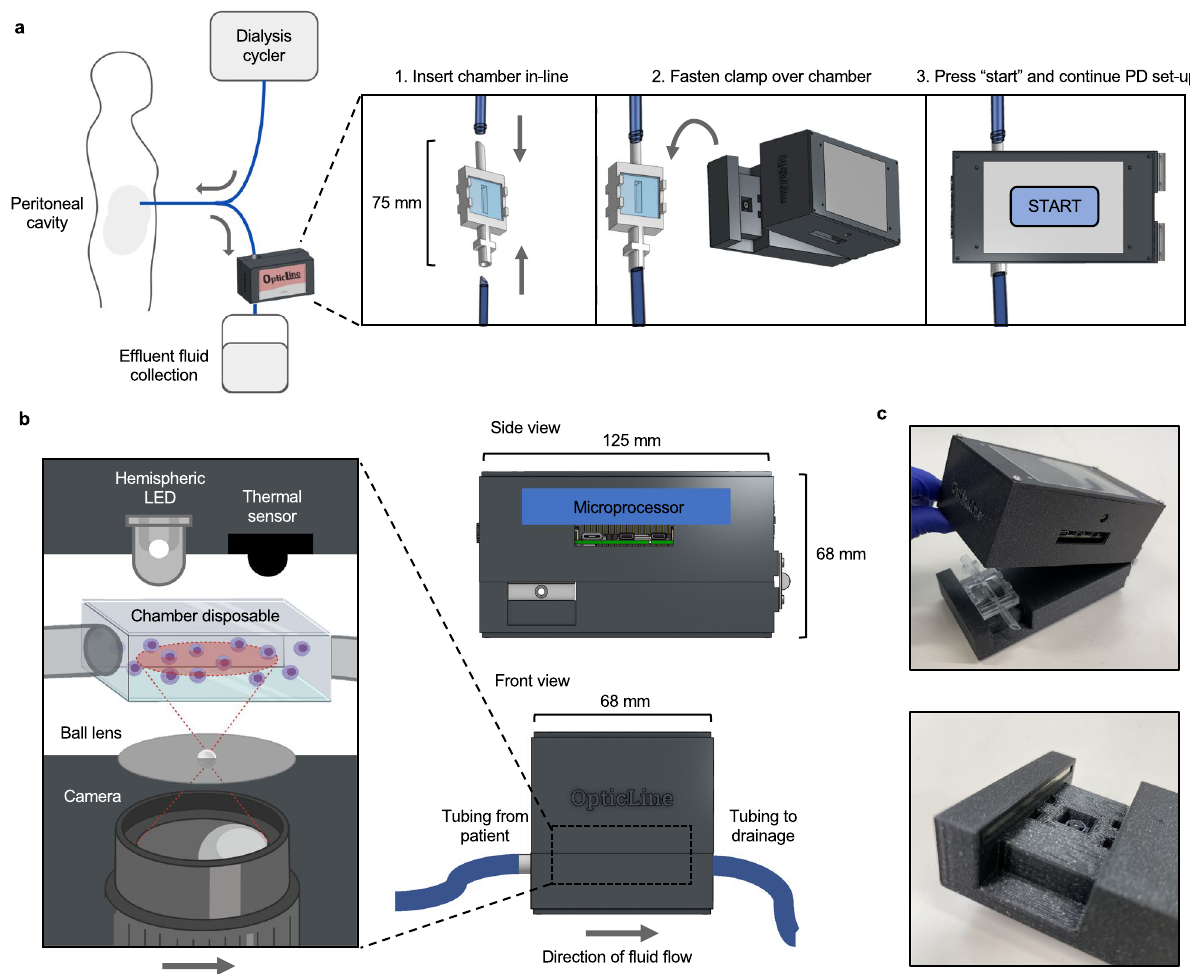
Figure 1. Overview of OpticLine use and mechanical construction. ( a ) The OpticLine chamber is inserted in-line with the drainage tubing, between the drain line and effluent fluid collection, when the patient is setting up for their peritoneal dialysis (PD) session. The OpticLine clamp then clamps over the chamber and images effluent as it flows through the clamp during drain times. The user interacts with the device via a touchscreen on the top of the clamp, and presses “Start” when they begin their PD session. Created with Onshape.com. ( b ) As labelled on front and side views, the clamp is 125 mm long, 68 mm wide, and 68 mm tall. The top part of the clamp contains the microprocessor. The expanded view on the left shows the clamp’s optical components in relation to the viewing chamber. The top part of the clamp contains a hemispheric LED that provides backlight for the lens, and a thermal sensor that detects fluid flow through the chamber and signals to the microprocessor that the camera should begin capturing images. The bottom part of the clamp contains the camera, which is connected to the microprocessor, and a ball lens that magnifies the camera’s view 140×. Created with Onshape. com and BioRender.com. ( c ) Photographs of an OpticLine prototype. The top photo shows the entire clamp with the chamber inserted. The bottom photo is a close-up of the clamp’s optical interface. The microscope lens is recessed in the square hole, and the four small rectangular divots mate with prongs on the chamber to prevent it from sliding during